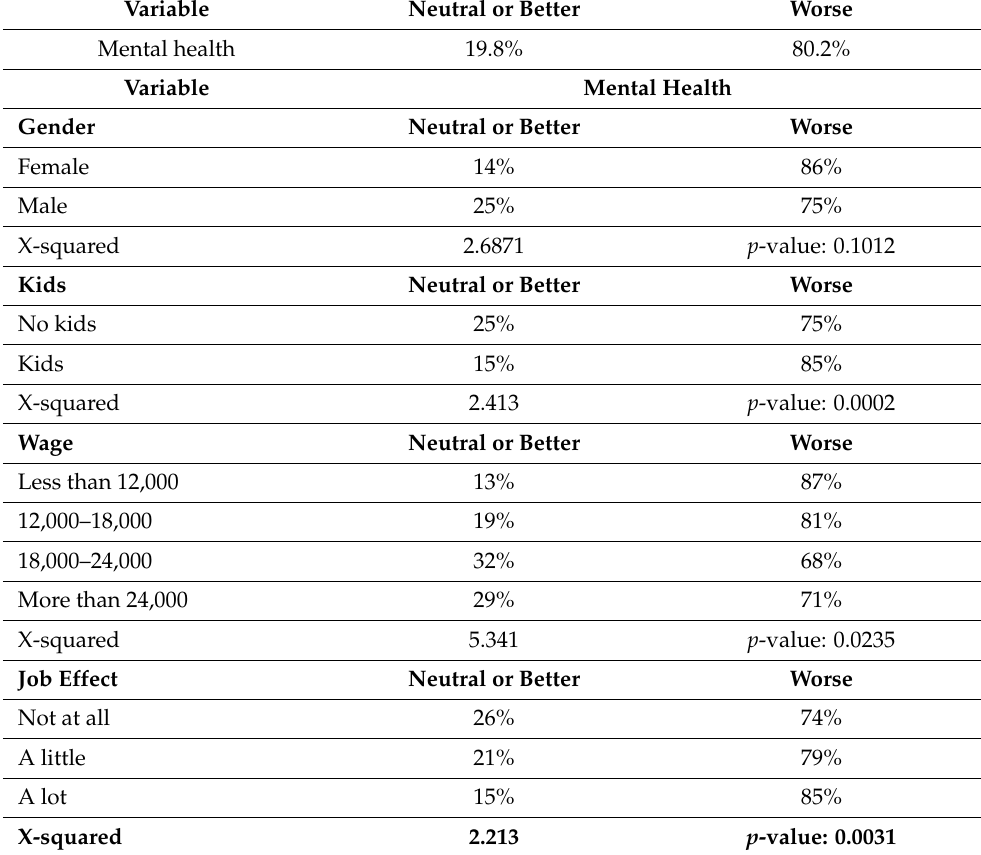
Table 3. Mental Health vs. some of our